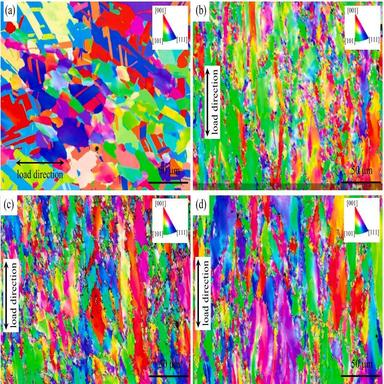
IPFz figure of the specimens (a) before after creep test (b) 150, (c) 180, and (d) 210 MPa.